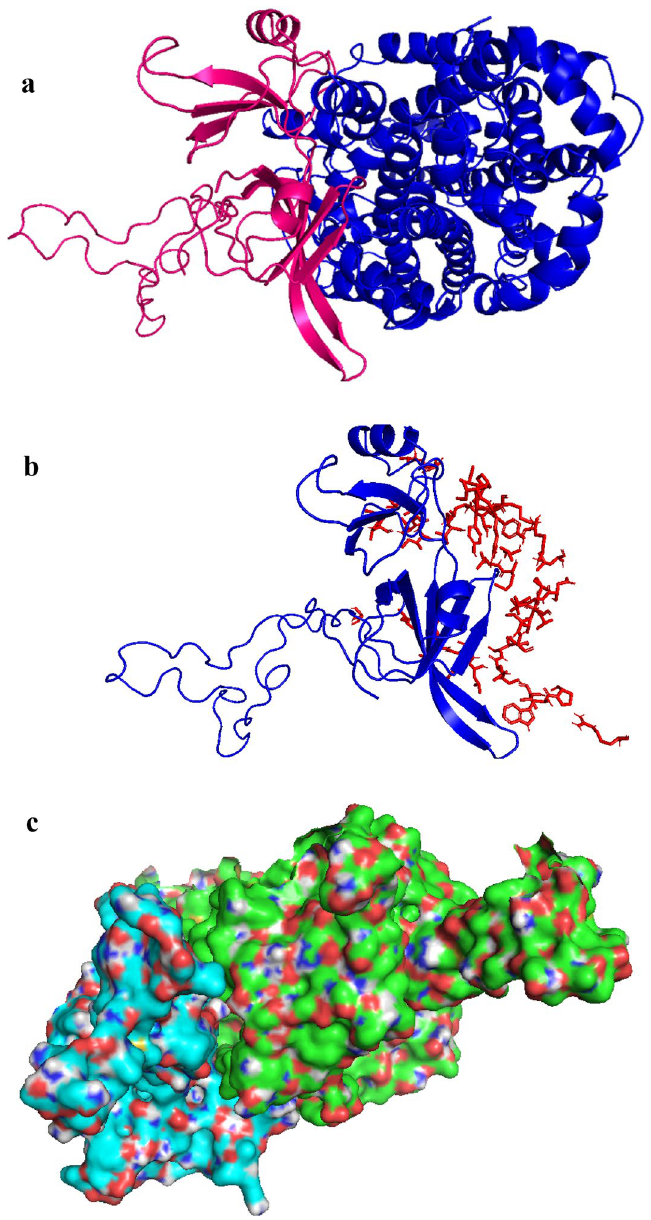
Figure 7. Best docked model of multi-epitope vaccine/receptor using ( a ) ClusPro 26 , ( b ) PyMOL 37 and ( c ) cartoon